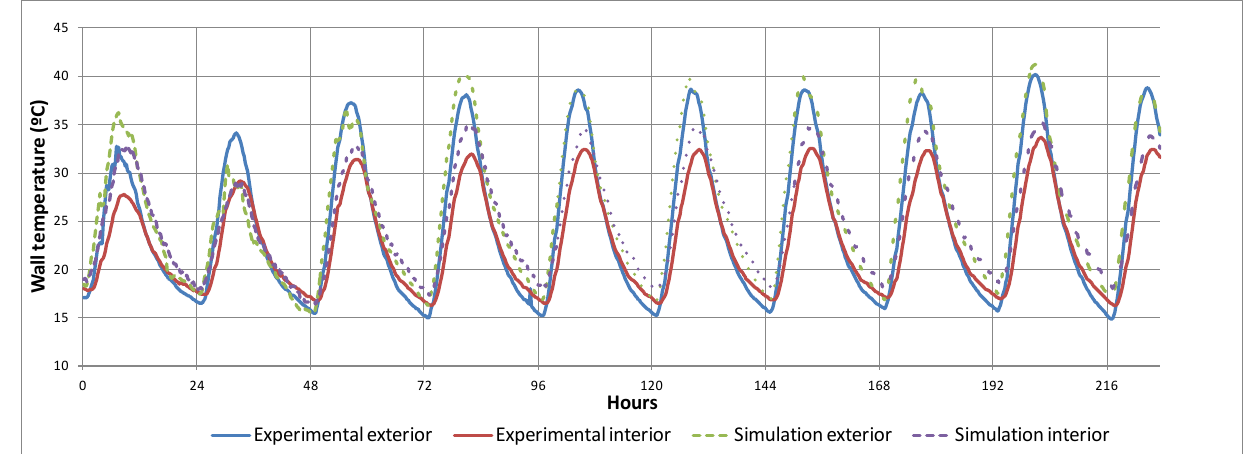
Figure 8. Measure and predicted temperatures of the south wall of the cubicle.